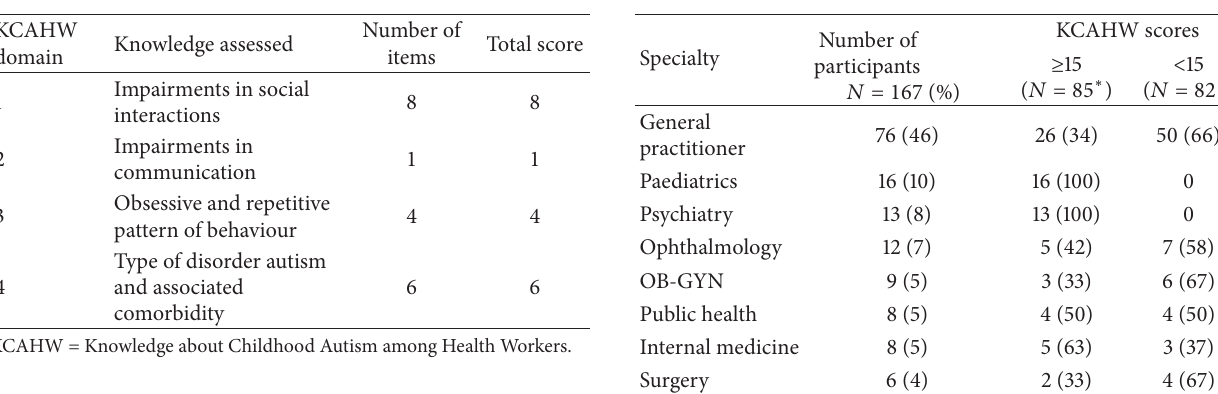
Table 1: KCAHW questionnaire’s domains, items, and scores [4]. Table 2: Participants, their specialties, and KCAHW